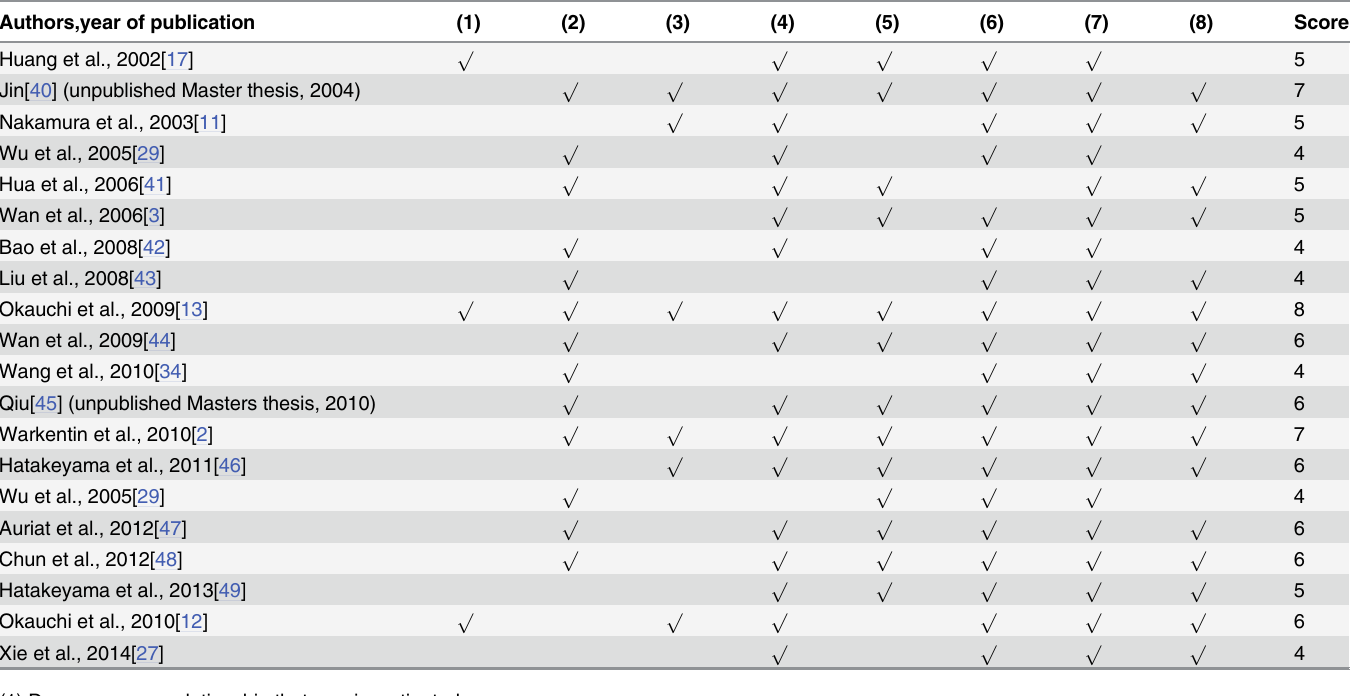
Table 2. Quality characteristics of included